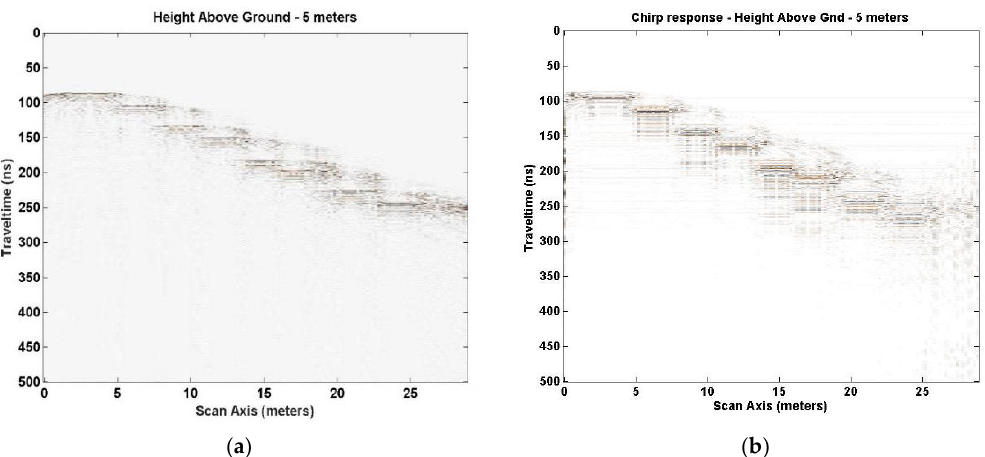
Figure 15. ( a ) Output response of SA2, EM sum of frequency signals with direct arrival and ground bounce signals removed [5]. ( b ) Output response of SA2 model, chirp excitation function with the direct arrival and ground bounce signals removed.